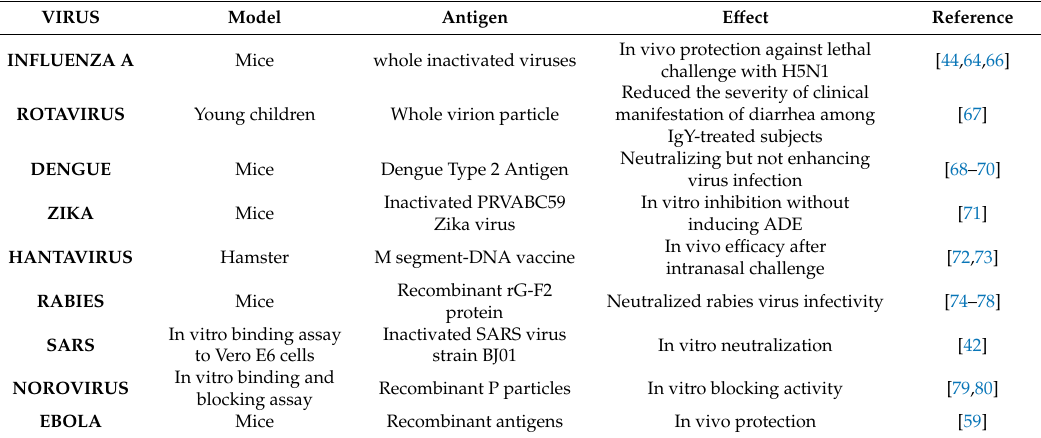
Table 3. E ffi cacy of the utilization of IgY in viral